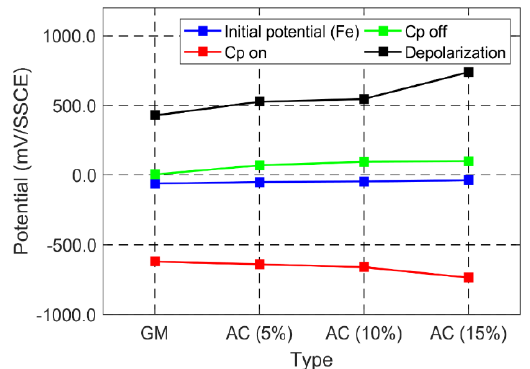
Figure 11. Depolarization potential measurement.